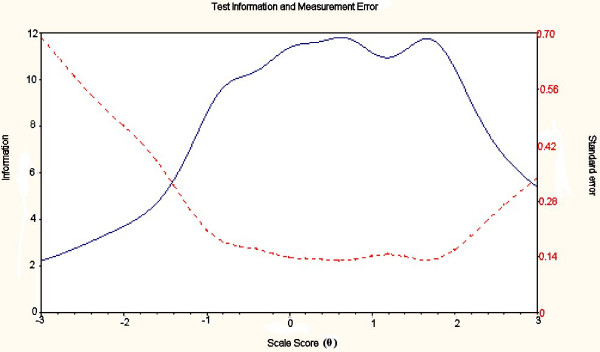
Total information across the construct for Ab-P.Test information curve - solid line; Standard error curve - dotted line.